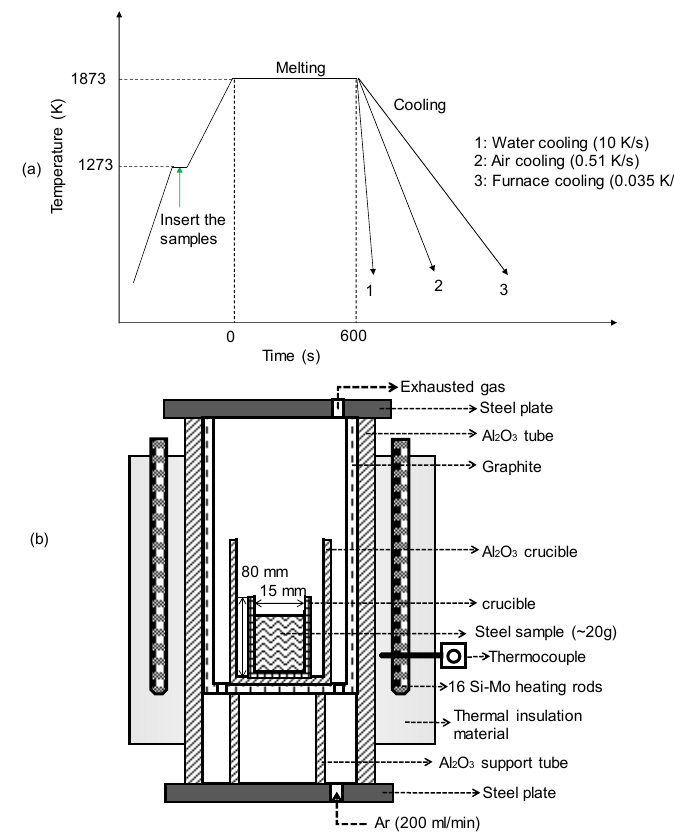
Figure 1. Schematic illustrations of ( a ) the thermal history for re-melting and cooling treatments of the specimens and ( b ) the Si-Mo resistance furnace employed in this study.